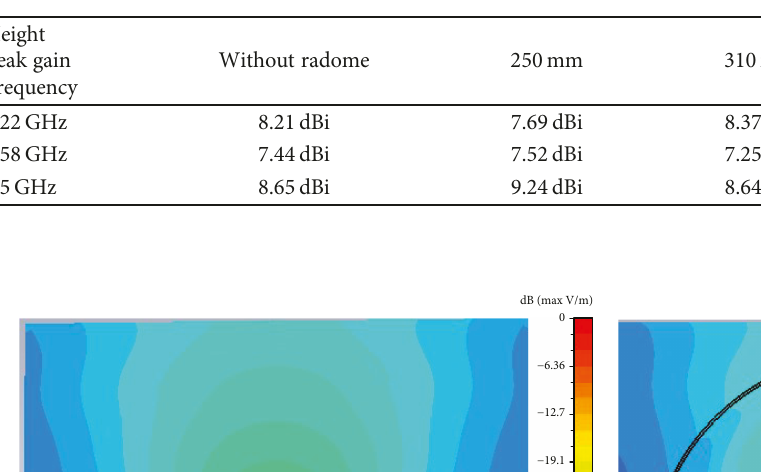
Table 4: Peak gain of di ff erent heights of radomes at selected frequencies.